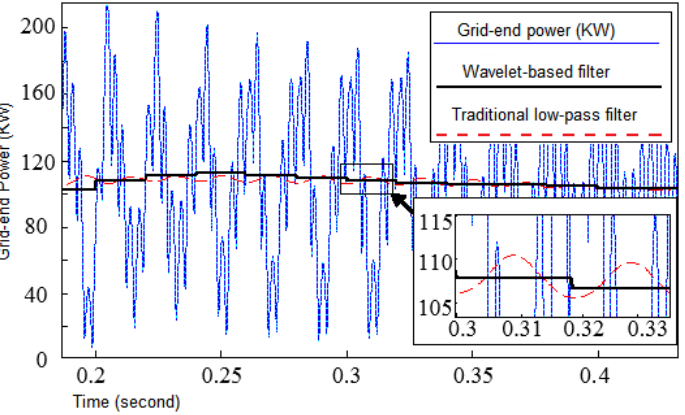
Figure 9. Positive component of grid-end active power extracted by the proposed wavelet-based low-pass filter and the conventional low-pass filter.